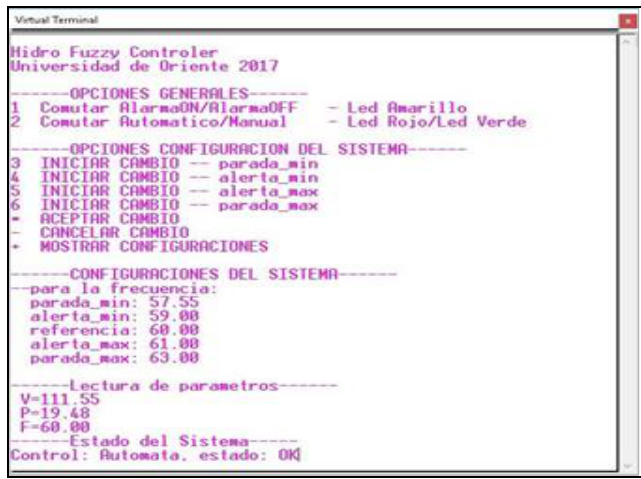
Figura 9: Simulación serie, para la comunicación de la propuesta. Fuente: Los Autores, (2018).